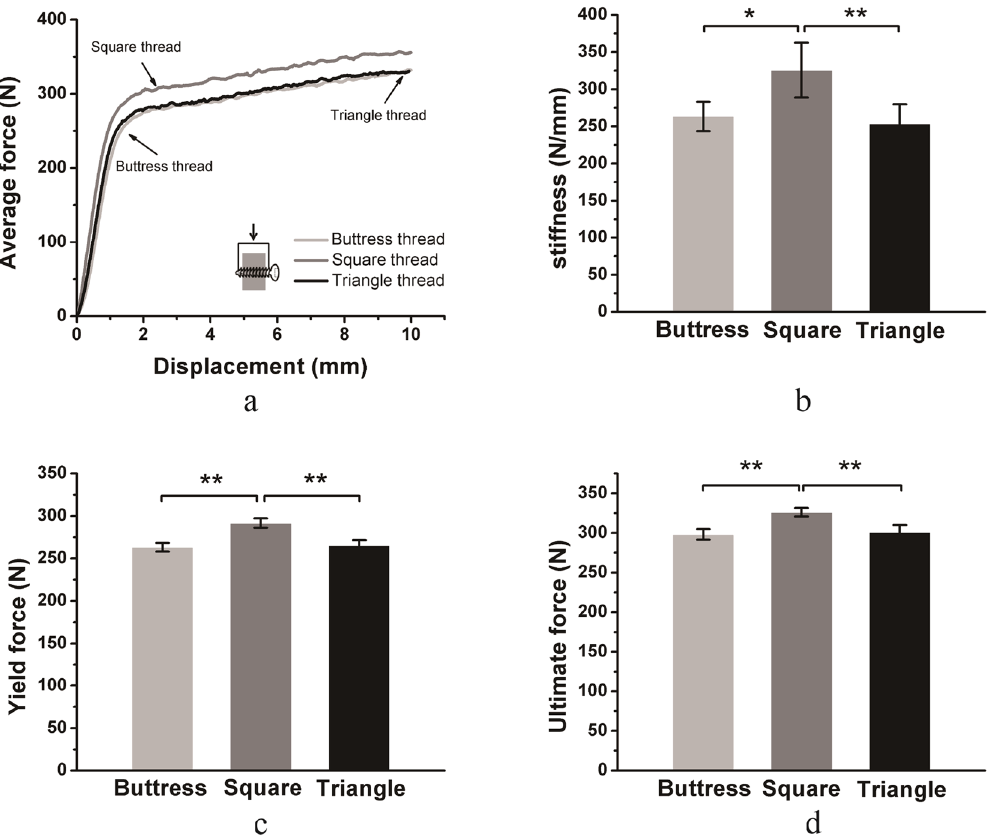
Figure 4. Comparison of the lateral migration resistance of screws with different threads. Mean values ± standard deviation of the measured values are presented (N = 5) (one-way ANOVA, *p < 0.05, **p < 0.01). ( a ) Force–displacement curves of the lateral migration resistance test. ( b – d ) Stiffness, yield force, and ultimate force of the force–displacement